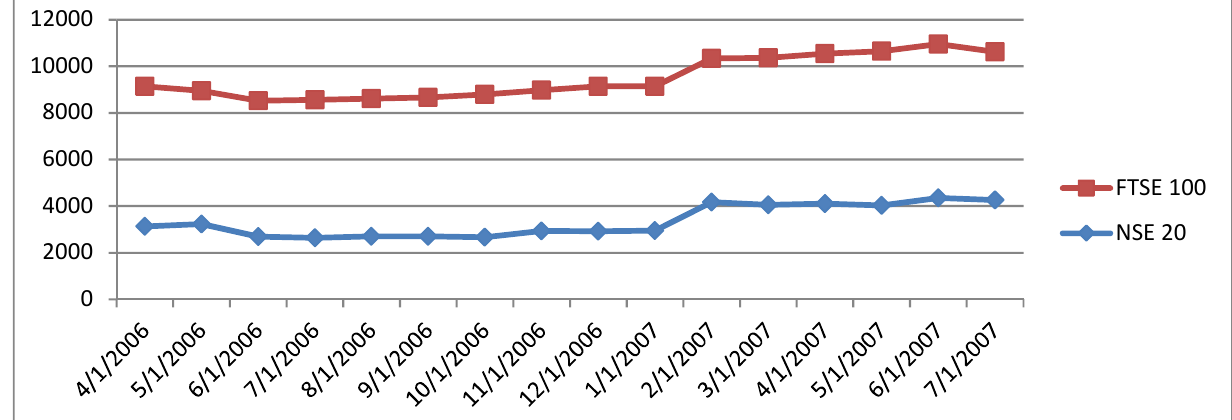
Fig. 1. Influence of NSE 20 Share Index on FTSE 100 Index during the Pre-Crisis